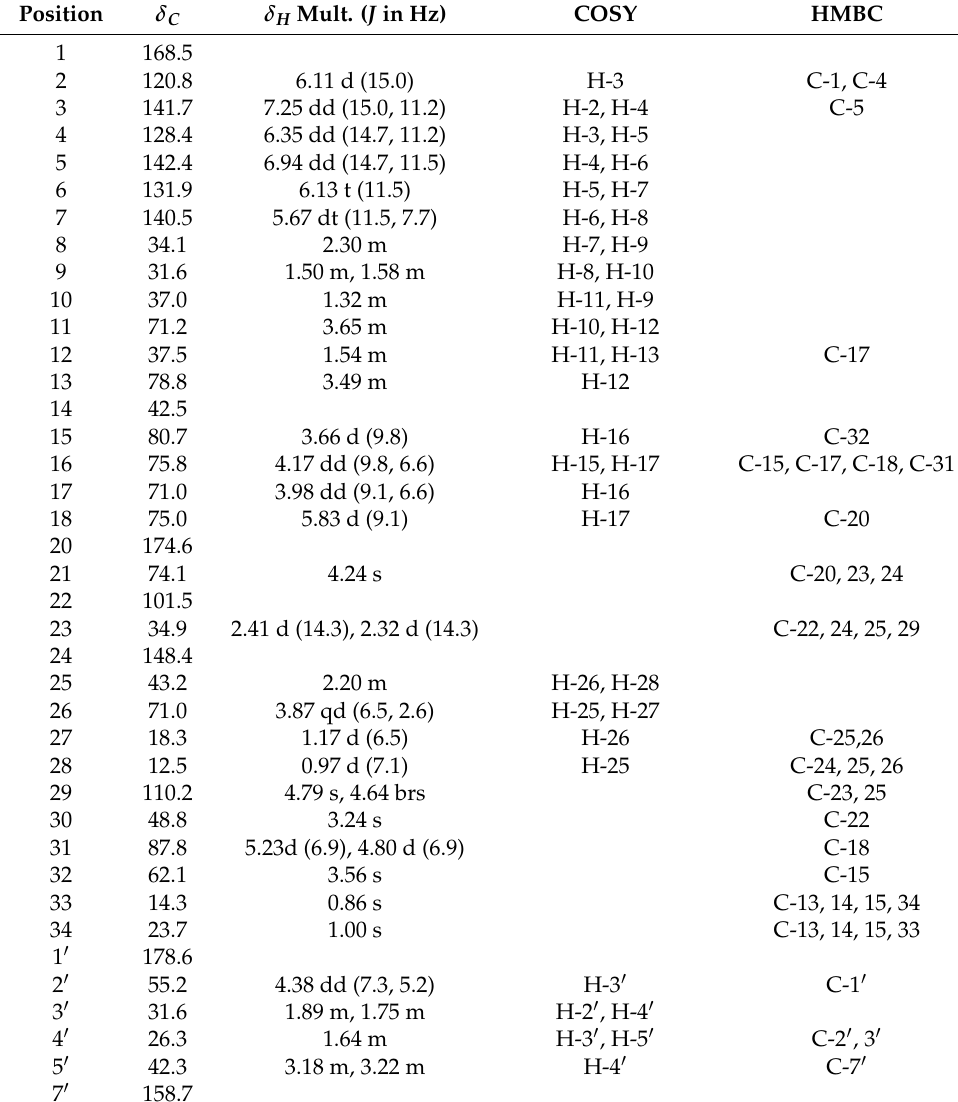
Table 2. NMR spectral data for 6 Z -onnamide ( 2 ) in CD 3 OD (400/150